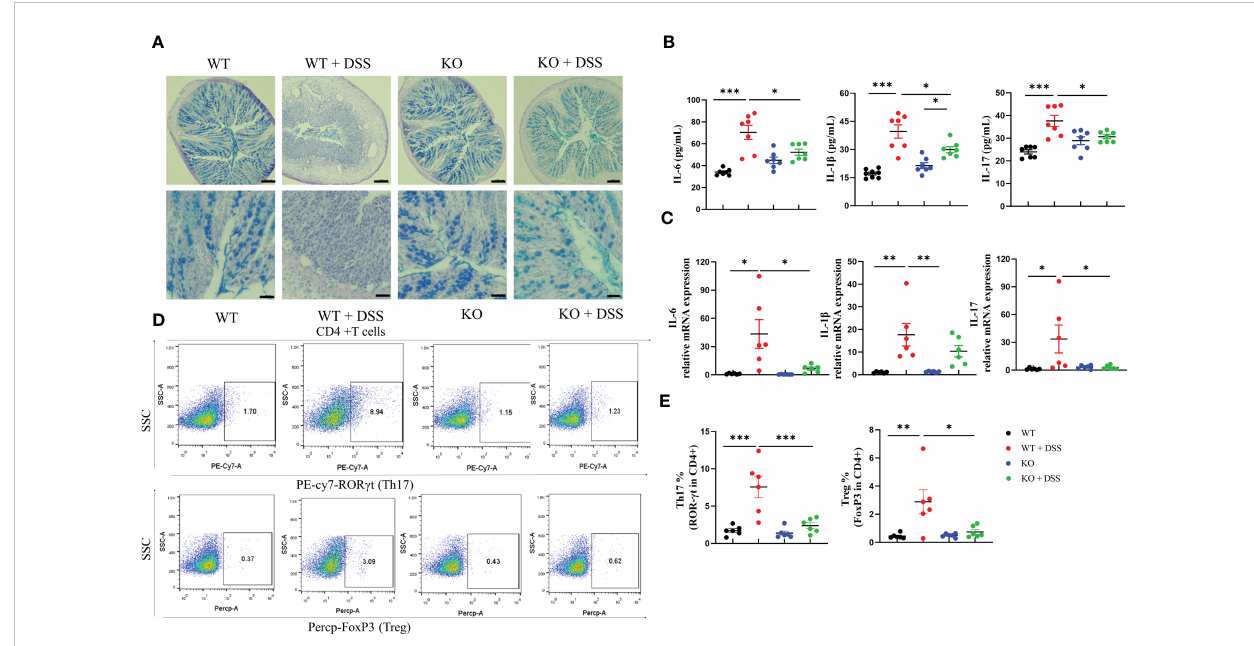
FIGURE 4 PAD4 de fi ciency improved gut barrier dysfunction and suppressed in fl ammatory responses in acute DSS-induced colitis. (A) Representative AB staining images of colon tissue. Bars represent 100 µm (10×; the upper panel.) and 50 µm (20×; the bottom panel) images. (B) The protein expression of IL-6, IL-1 b and IL-17 in colon tissues (n=6-8). (C) RT-qPCR results of cytokines IL-6, IL-1 b and IL-17 in colon tissues (n=6-8). (D) Representative fl ow cytometry plots of Th17 cells and Treg cells in MLNs. (E) Quantitative analyses of the percentages of Th17 and Treg cells in MLNs (n=6). * P<0.05 , ** P<0.01 , *** P<0.001